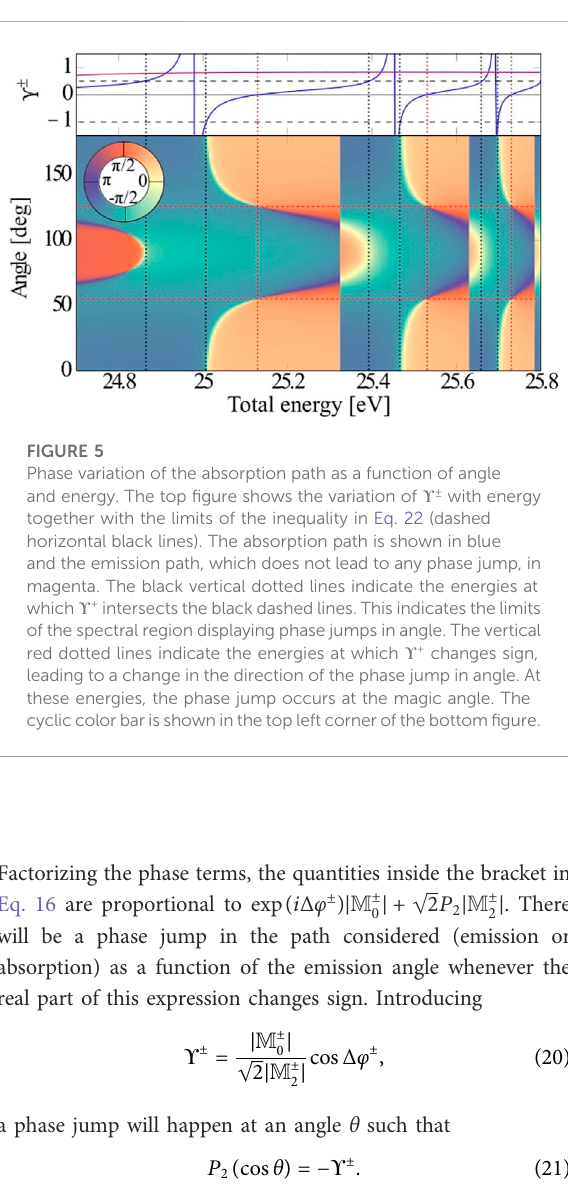
contrast exhibit different energy regions with or without a phase jump, depending on whether Eq. 22 is ful fi lled or not. Because of the non-zero imaginary part of angle is smaller than π rad. The direction of the phase jump depends on the sign of Δ φ + . This is illustrated in Figure 5, showing both ϒ ± as a function of energy, and the phase variation of the absorption path as a function of angle (vertical axis) and energy (horizontal axis). The black dashed lines indicate the different energy regions, where a phase jump as a function of angle is to be or not be expected.